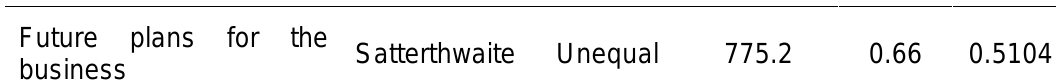
Table 13: Significant Differences Relating to Motivation Variable